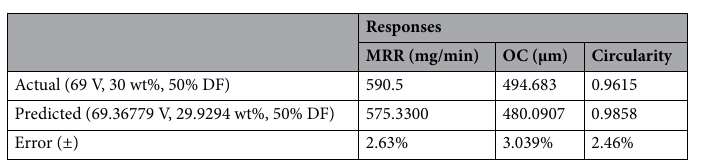
Table 5. Validation test results.